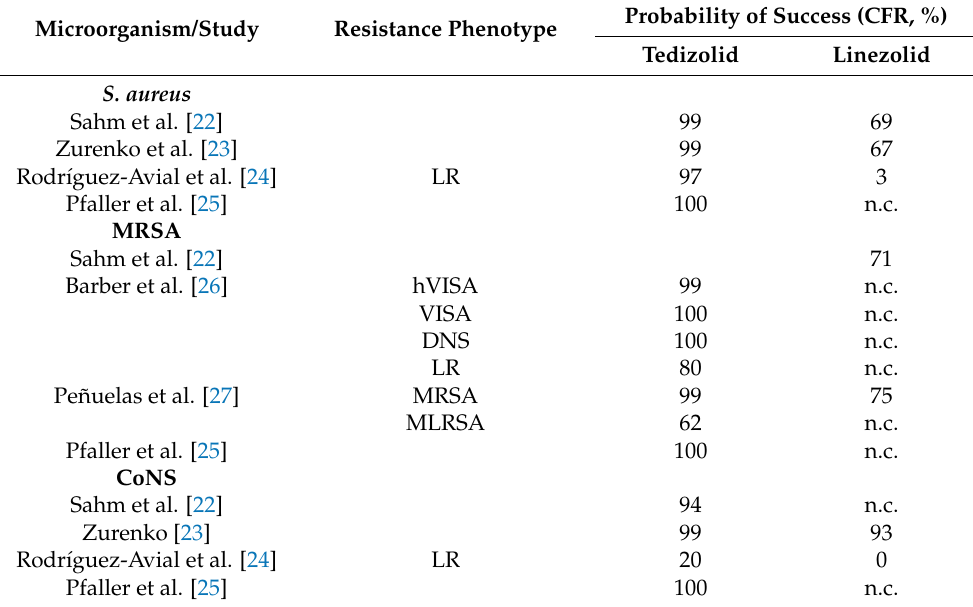
Table 5. Probability of success (expressed as CFR or cumulative fraction of response) of tedizolid and linezolid for staphylococci. Microorganism/Study Resistance Phenotype